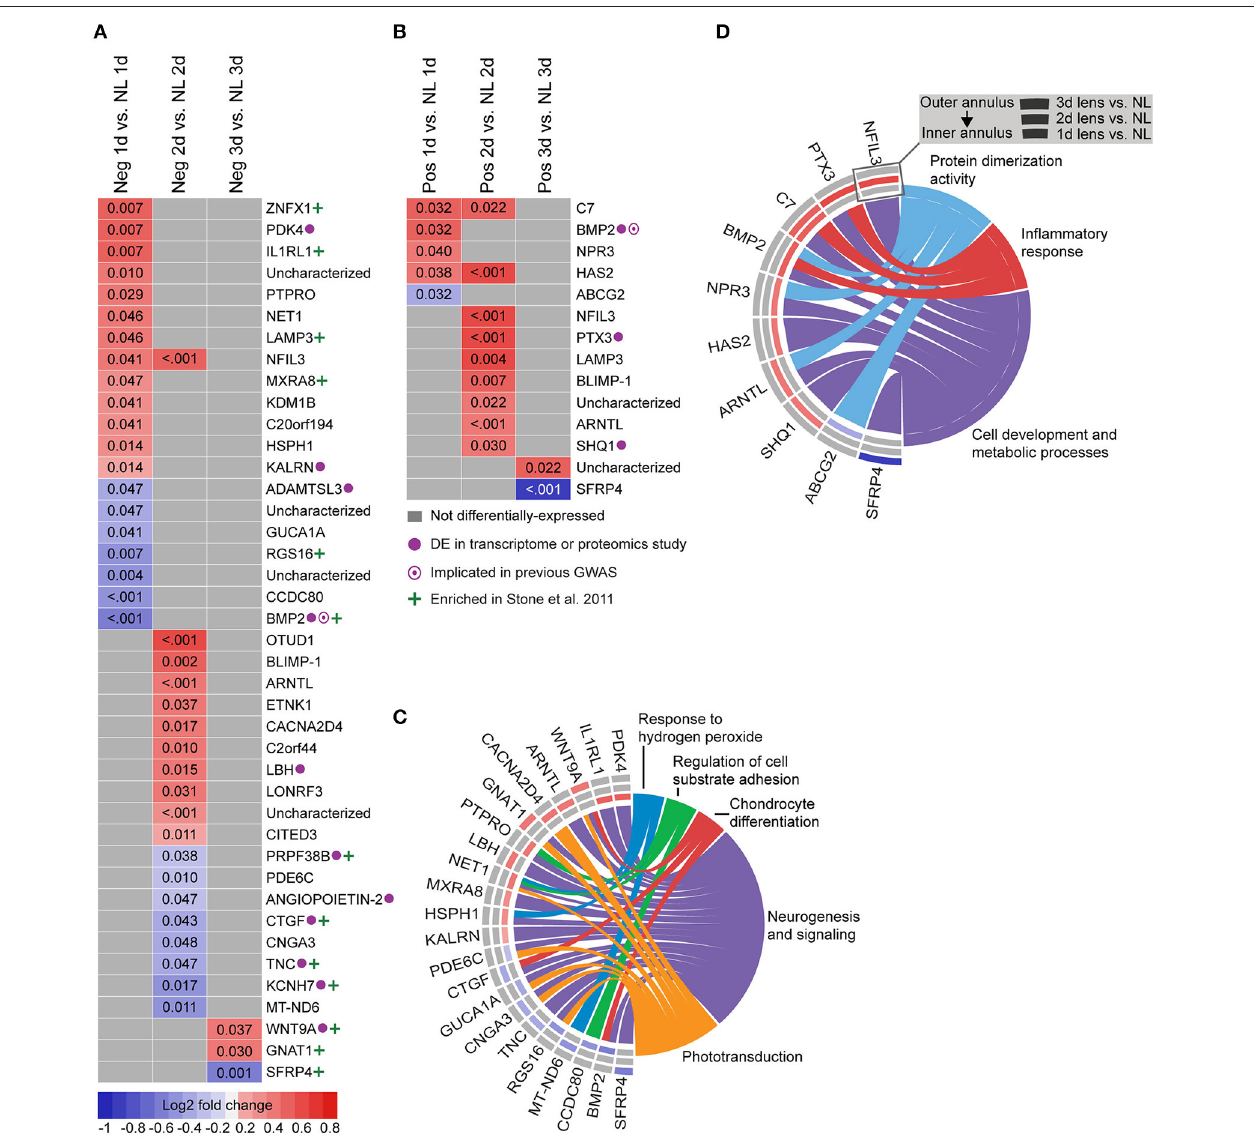
FIGURE 2 | Differential expression of single genes in lens relative to no lens groups. (A) Heatmap showing genes differentially expressed following 1, 2, and 3 days of negative lens induced myopia induction. (B) Heatmap showing genes differentially expressed following 1, 2, and 3 days of positive lens induced hyperopia induction. Fold change is indicated by grid color (red = up-regulation, blue = down-regulation, gray = not differentially-expressed) and Benjamini–Hochberg adjusted p -values are super-imposed on the grid. Purple symbols indicate genes implicated in past exploratory animal or human studies of refractive error. Green symbols indicate genes enriched at the top or bottom of a comparable microarray dataset (see Supplementary Figure S3 for details) (C) Chord diagram showing over-represented GO terms for the genes differentially-expressed during myopia induction (i.e., all genes shown in “A”). (D) Chord diagram showing over-represented GO terms for the genes differentially-expressed during hyperopia induction (i.e., all genes shown in “B”). For chord diagrams, over-represented GO terms are shown on the right and genes contributing to this over-representation are shown on the left. Squares following gene symbols indicate whether a gene was differentially-expressed following 1, 2, or 3 days of lens-wear. For details of differential gene expression see Supplementary Table S7. For details of commonalities with past studies see Supplementary Table